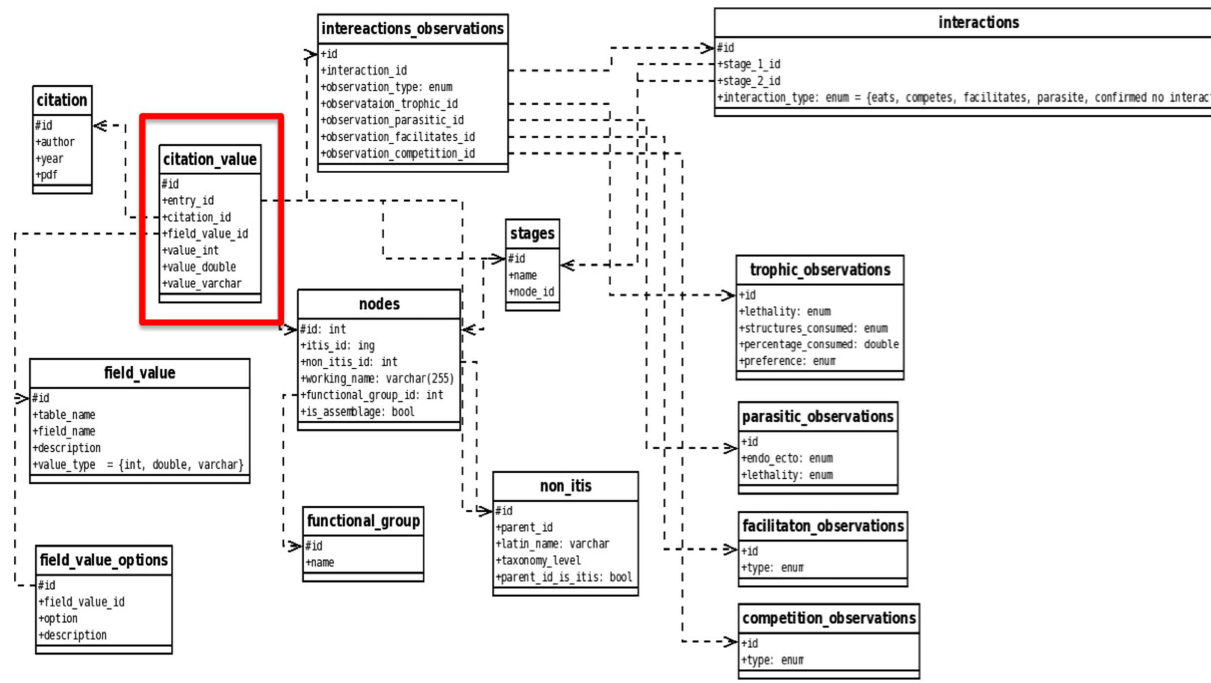
Figure 1. Database schema to enter, query and retrieve data for parameterizing ecological network models. The central element of the schema is the citation value table that links all entries and queries to the data source (red box). The ITIS identifier in the ‘‘nodes’’ table (red line) is used to link the kelpforest database to the ITIS database.